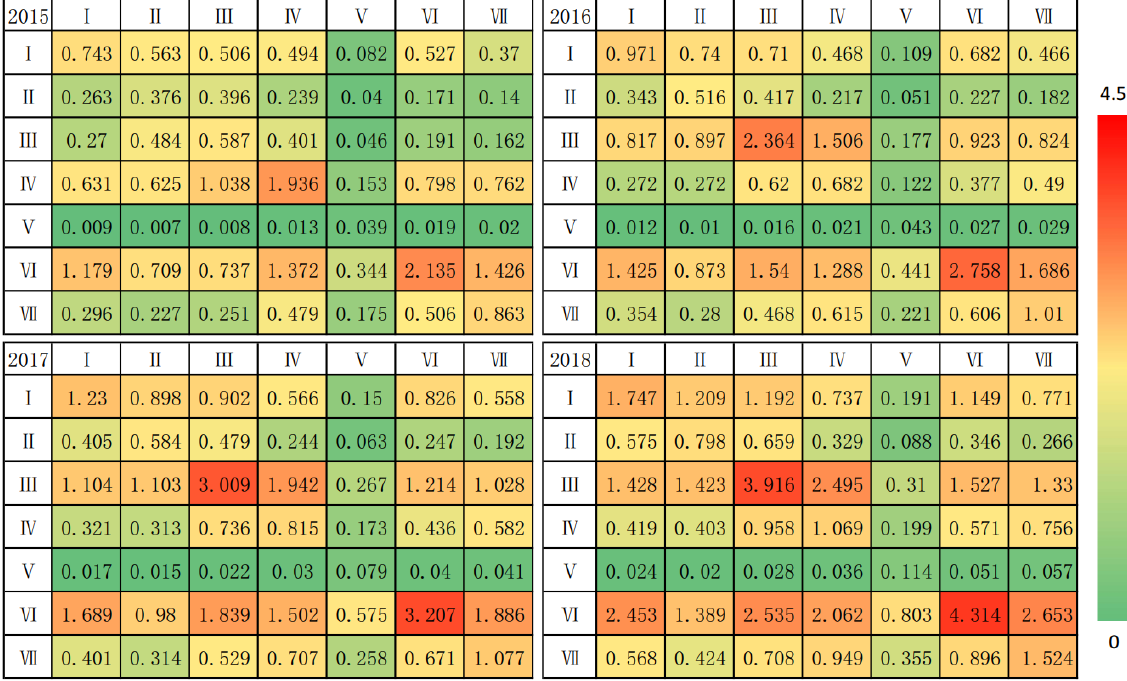
Figure 7 . Correlation density matrix of different subgroups from 2015 to 2018: I, II, III, IV, V, VI, and VII in the figure indicate subgroup numbers. Subgroup locations are displayed in Figure 6.